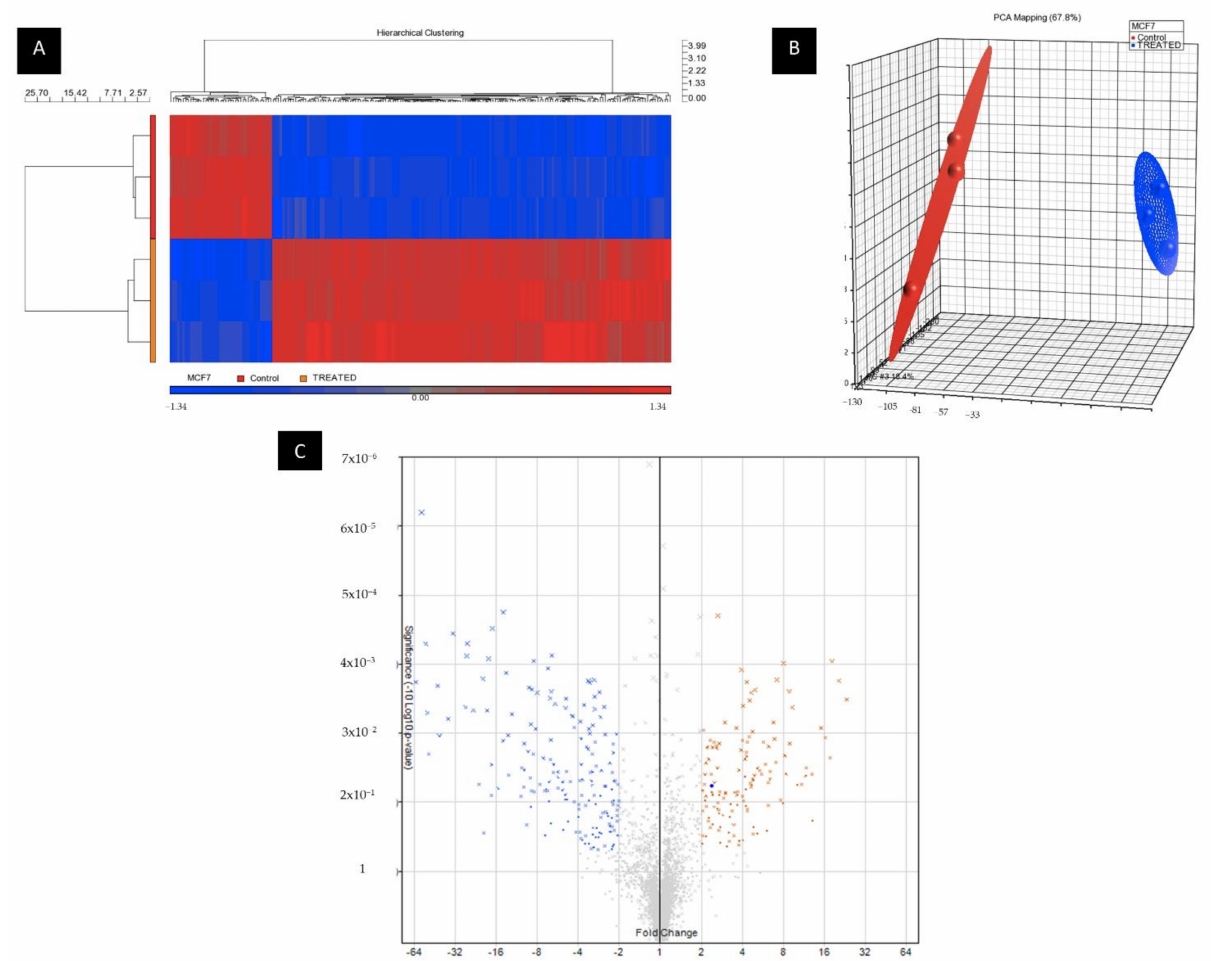
Figure 3. miRNA microarray data revealed differential gene expression between control and BHMC treated MCF-7 cell; ( A ) heatmap cluster analysis depicting differential miRNA (>2-fold change, p < 0.05) for BHMC treated cells and control MCF-7 cells. Up-regulated genes are depicted in red, down-regulated genes are in blue (see color bar); ( B ) principal component analysis plot; Tthe closer the dots, the more similar the gene expression profiles are; the farther apart the dots are, the greater the differences are; ( C ) volcano